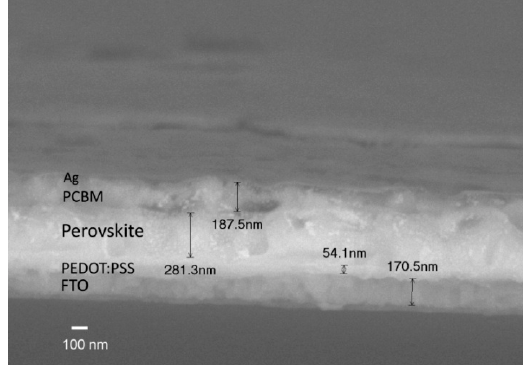
Figure 10. The SEM cross-sectional image of the perovskite solar cell.